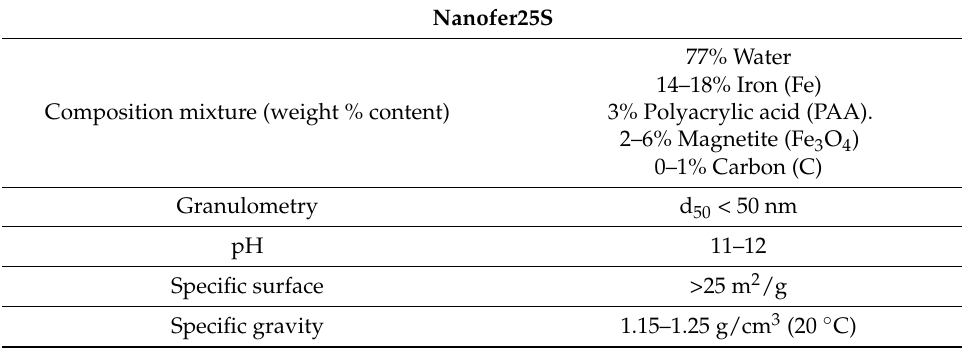
Table 1. Main features of the Nanofer25S solution.